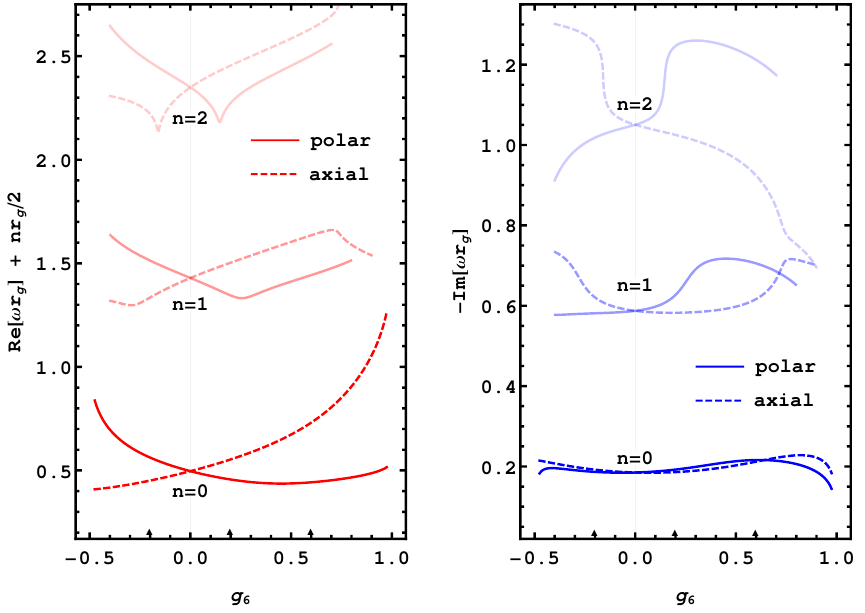
Figure 5 . Real (left-hand panel) and imaginary (right-hand panel) part of the first multipole ( ‘ = 1 ) QNMs in the massless case. Continuous (dashed) lines indicate polar (axial) modes. At g 6 = 0 the polar and axial mode agree (isospectrality). For any non-vanishing g 6 6 = 0 isospectrality is broken. We show the fundamental ( n = 0 ) as well as first ( n = 1 ) and second ( n = 2 ) overtone in increasingly lighter shading. Where the curves end, spectral methods with N = 80 are found to be insufficient to ensure proper convergence. Exemplary convergence plots (for the points marked with triangles on the g 6 -axis) are presented in appendix